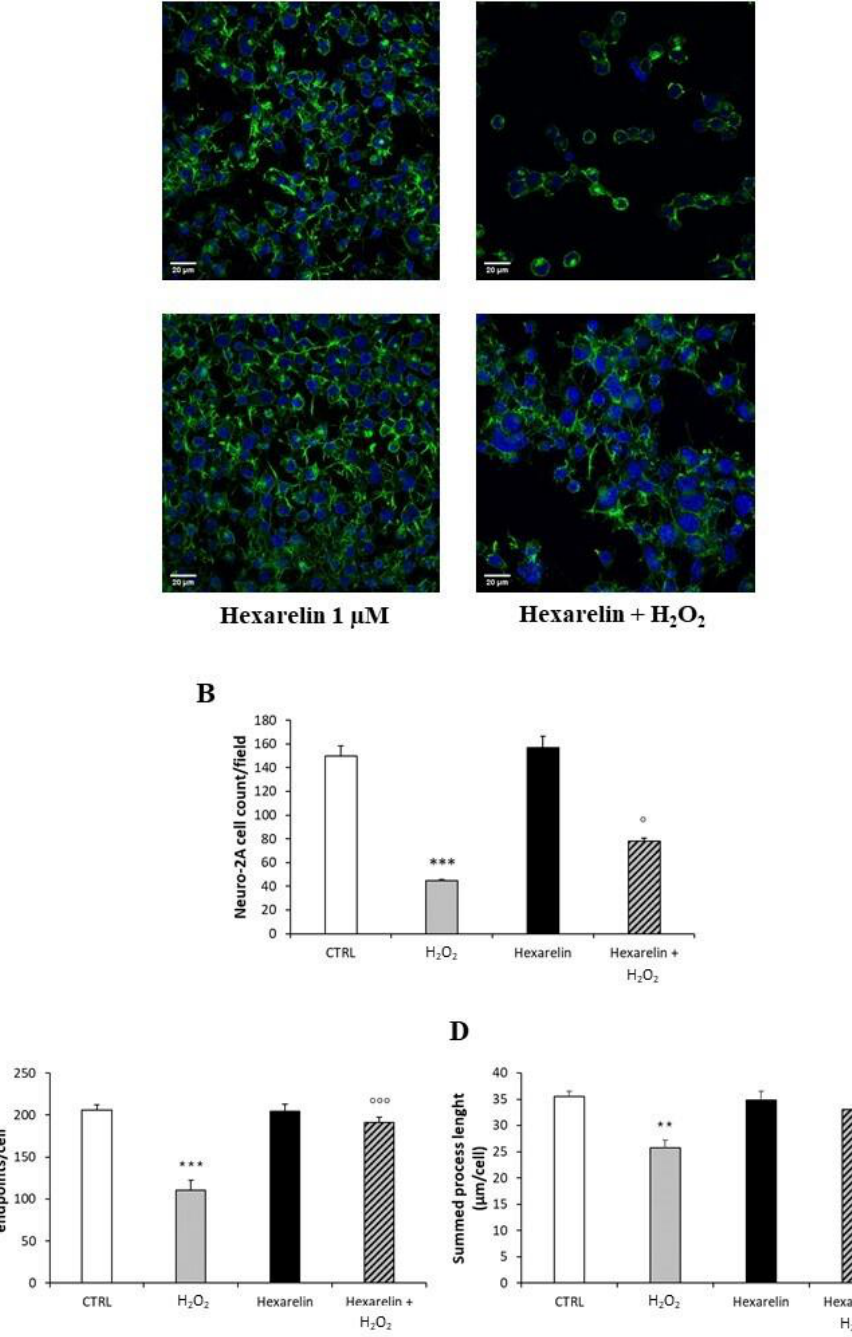
Figure 4. Hexarelin reduces Neuro-2A cells de-ramification induced by H 2 O 2 . ( A ) Neuro-2A cells were seeded on poly-D-lysine pre-treated coverslips and incubated for 24 h with or without hexarelin and 100 µ M H 2 O 2 . At the end of the treatment, cells were fixed and stained for phalloidin and DAPI. Images were captured with confocal laser scan microscope. Scale bar: 20 µm. ( B ) Graphical representation of the number of cells in the same areas per each treatment, ( C ) of the process endpoints/cells and ( D ) process length/cells. Data are expressed as mean ± SEM of 3 replicates (total number of cells analyzed = 160). Statistical significance: ** p < 0.01, *** p < 0.001 vs. CTRL; ° p < 0.05, °°° p < 0.001 vs. H 2 O 2 . We used FracLac for ImageJ to investigate and quantify morphological changes of Neuro-2A cells as a consequence of treatments. Examples of cropped photomicrographs, binary and outline transformations are shown in Figure 5.